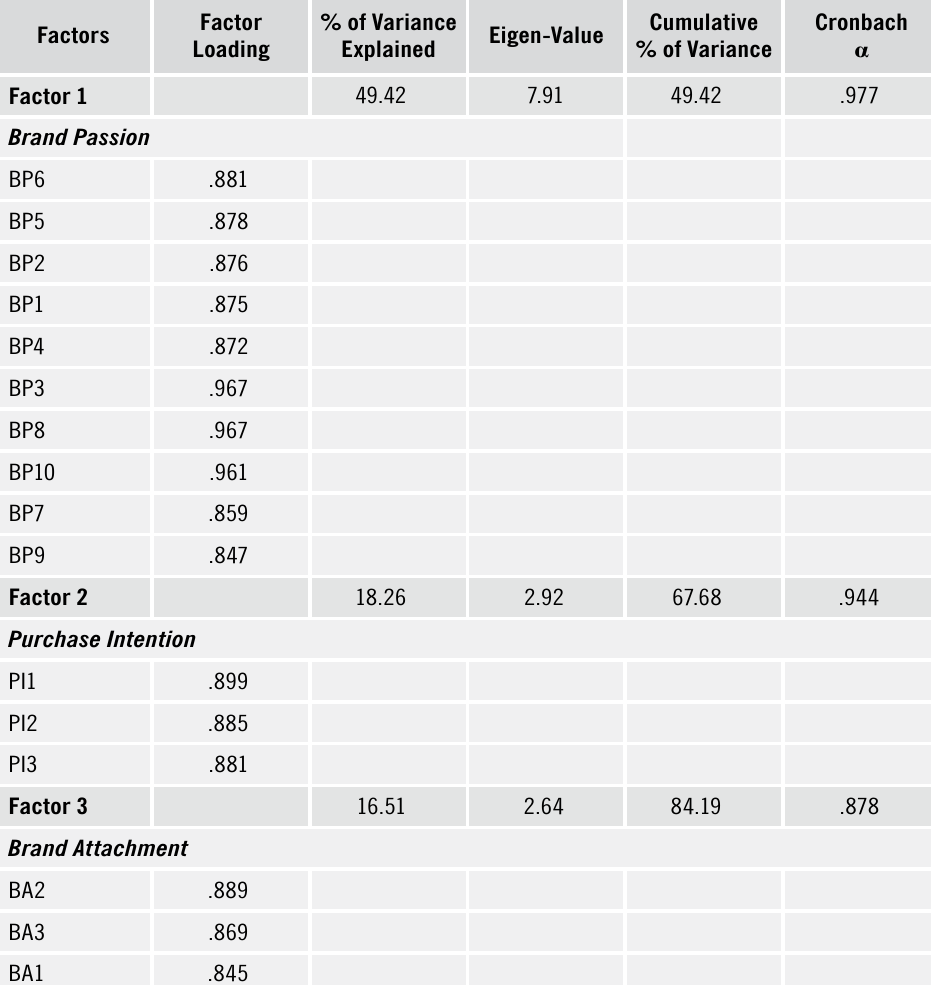
Table 2. Exploratory factor analysis for the three-factors